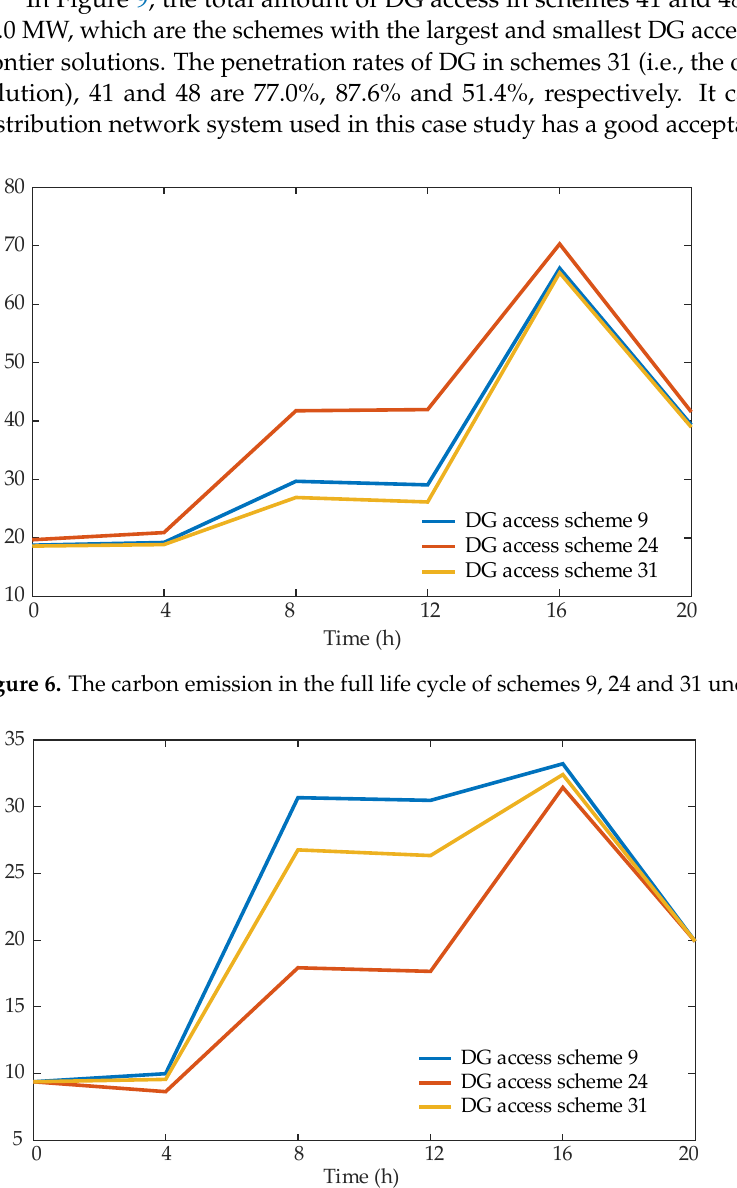
Figure 8. The line capacity margin of schemes 9, 24 and 31 under scenario 5. The total amount of DG access of each Pareto frontier solution is shown in Figure 9. In Figure 9, the total acceptance capacity of DG in schemes 9, 24 and 31 are 109.7 MW, 84.0 MW and 105.0 MW, respectively. It can be seen from Figures 7–9 that the larger the ac- ceptance capacity of DG, the greater the impact of DG on the distribution network. The increase of line capacity margin means the improvement of line load transfer capacity and the node voltage deviation means the power quality degradation.